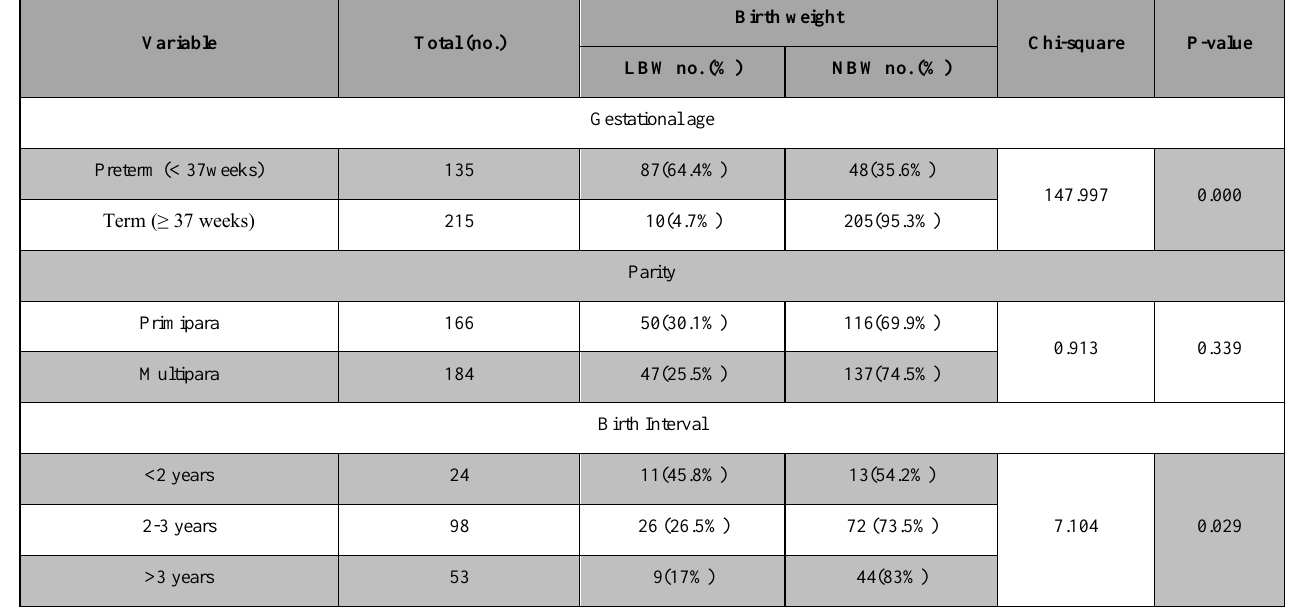
Table 4. Association of low birth weight with Gestational age, parity (n=350), and birth interval (n=175)*.